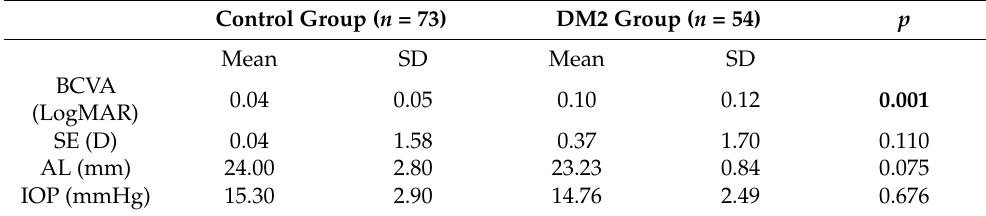
Table 2. Mean, standard deviation (SD) and statistical significance ( p value) of the best corrected visual acuity (BCVA) in the LogMAR scale, spherical equivalent (SE) in diopters (D), axial length (AL) in mm and intraocular pressure (IOP) in mmHg between the control and type 2 diabetes mellitus (DM2) groups. Differences that reached statistical significance with p < 0.05 are shown in bold. Control Group ( n = 73) DM2 Group ( n = 54) p Mean SD Mean SD BCVA 0.04 0.05 0.10 0.12 (LogMAR)